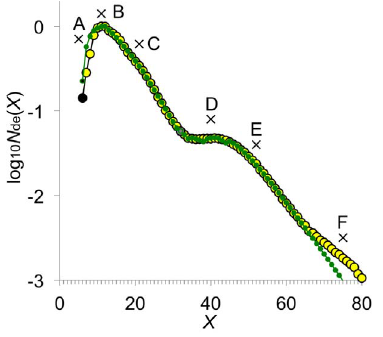
Figure 2. Rice (cv Nipponbare) amylopectin CLD fitted with the substrate-competing model. The amylopectin CLD was obtained by FACE [32]. X is the number of glucose residues on glucans released by unrestricted debranching of the starch. The black- and gray-filled circles are X =6 and 32, respectively. The fitting to the overall experimental CLD (yellow filled circles) is given as green filled circles. The range of fitting X up to < 60–70 is considered. Fitting procedures are given the Model section. Crosses mark the features of the